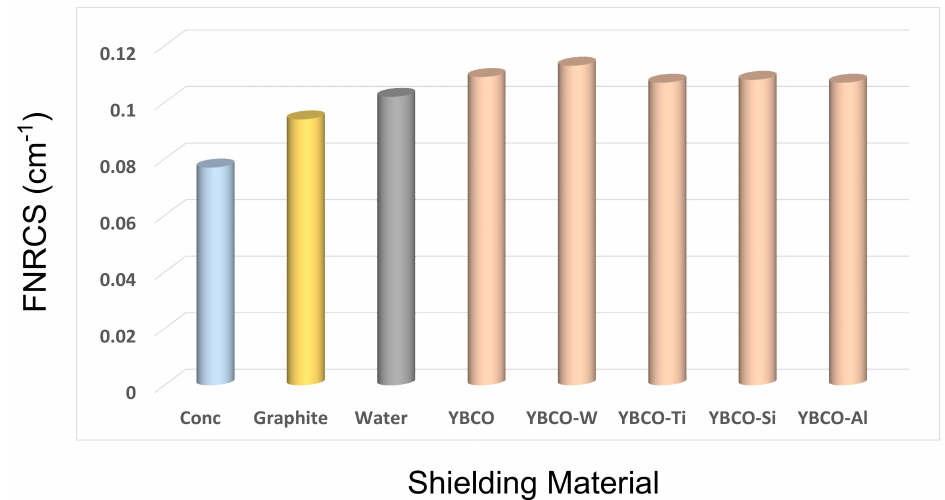
Figure 13. The comparison between the FNRCS values for fabricated samples and standard